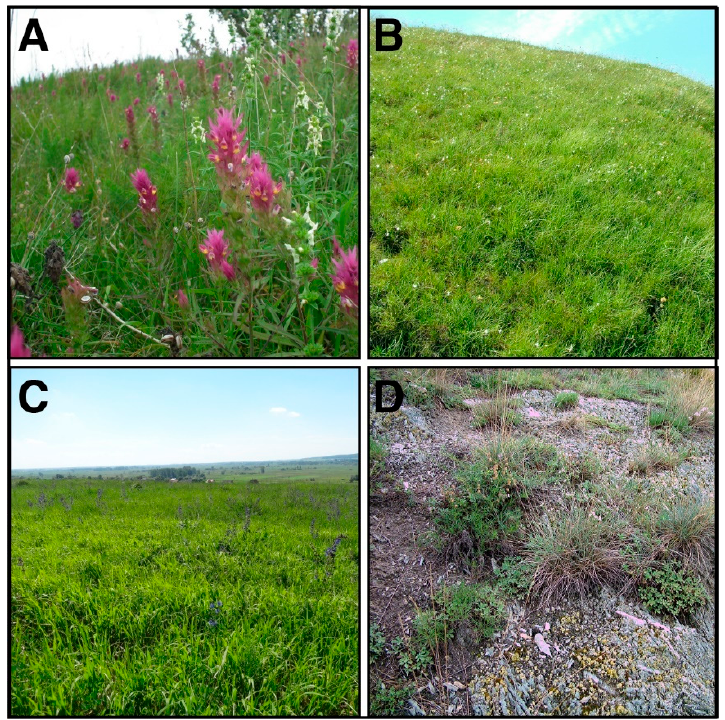
Figure 2. The representative xerothermic grassland habitats in the Nida Basin (southern Poland) where fungi were collected between 2010 and 2013: ( A ) Adonido-Brachypodietum pinnati , ( B ) Seslerio- Scorzonetum purpureae , ( C ) Thalictro-Salvietum pratensis , and ( D ) Festucetum pallentis .